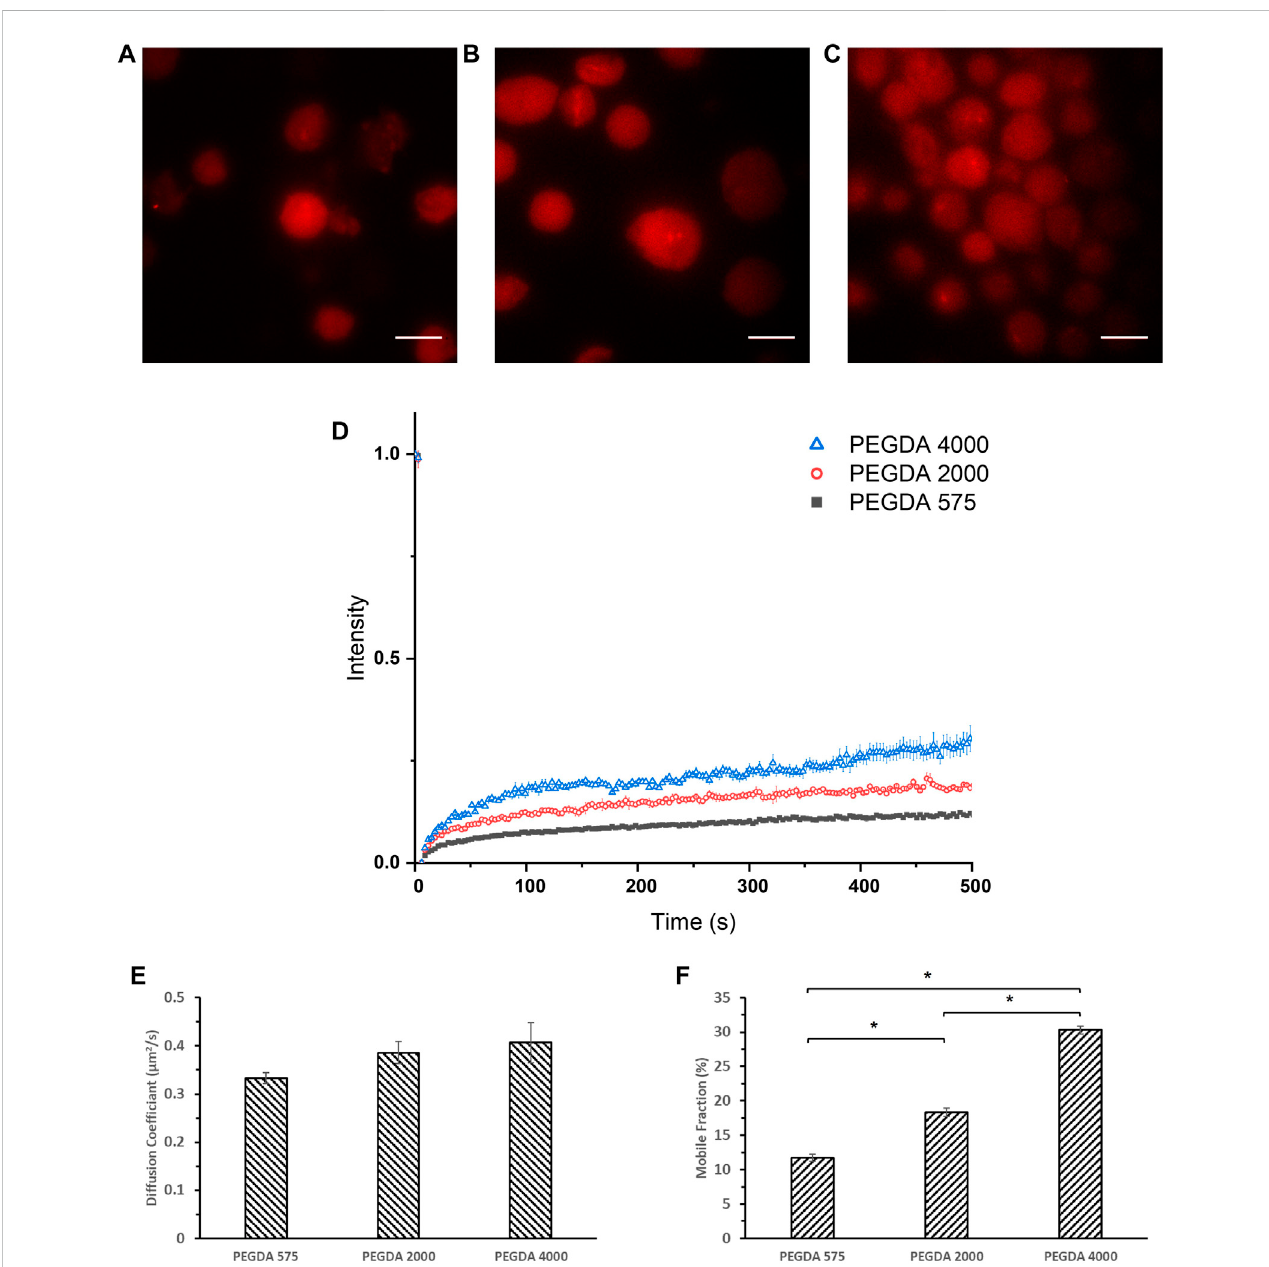
FIGURE 4 Confocal images of (A) crosslinked PEGDA 575 MLG, (B) crosslinked PEGDA 2000 MLG, (C) crosslinkedPEGDA 4000MLG and (D) FRAP recovery curves ofcrosslinkedPEGDA575MLG(BlackSquare),PEGDA2000MLG(RedCircle),PEGDA4000MLG(BlueTriangle).Unmarkedscalebarsinthe fi guresrepresent 20 μ m; (E) Diffusion Coef fi cients and (F) Mobile Fractions of PEGDA 575, 2000, 4,000 MLGs (* p <